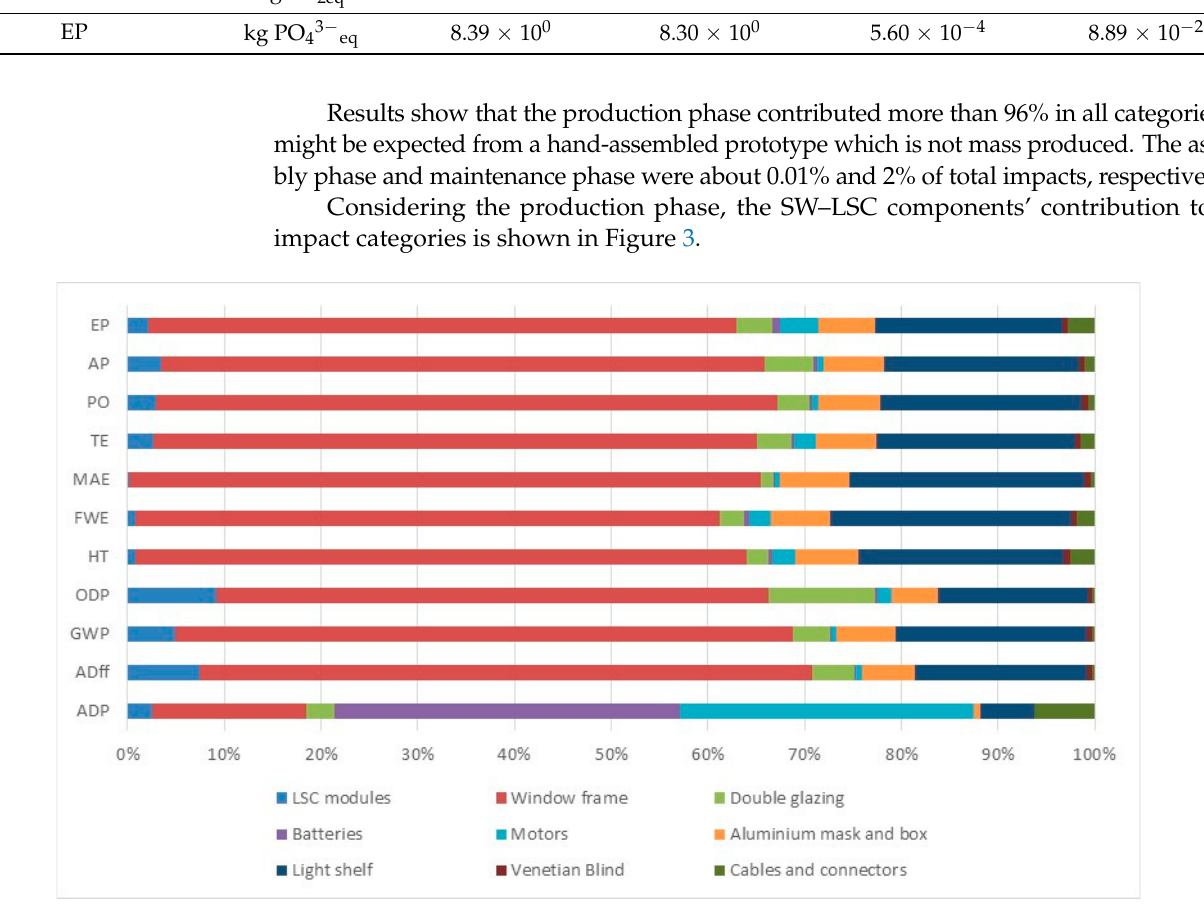
Figure 3. Contribution of SW–LSC elements to the total